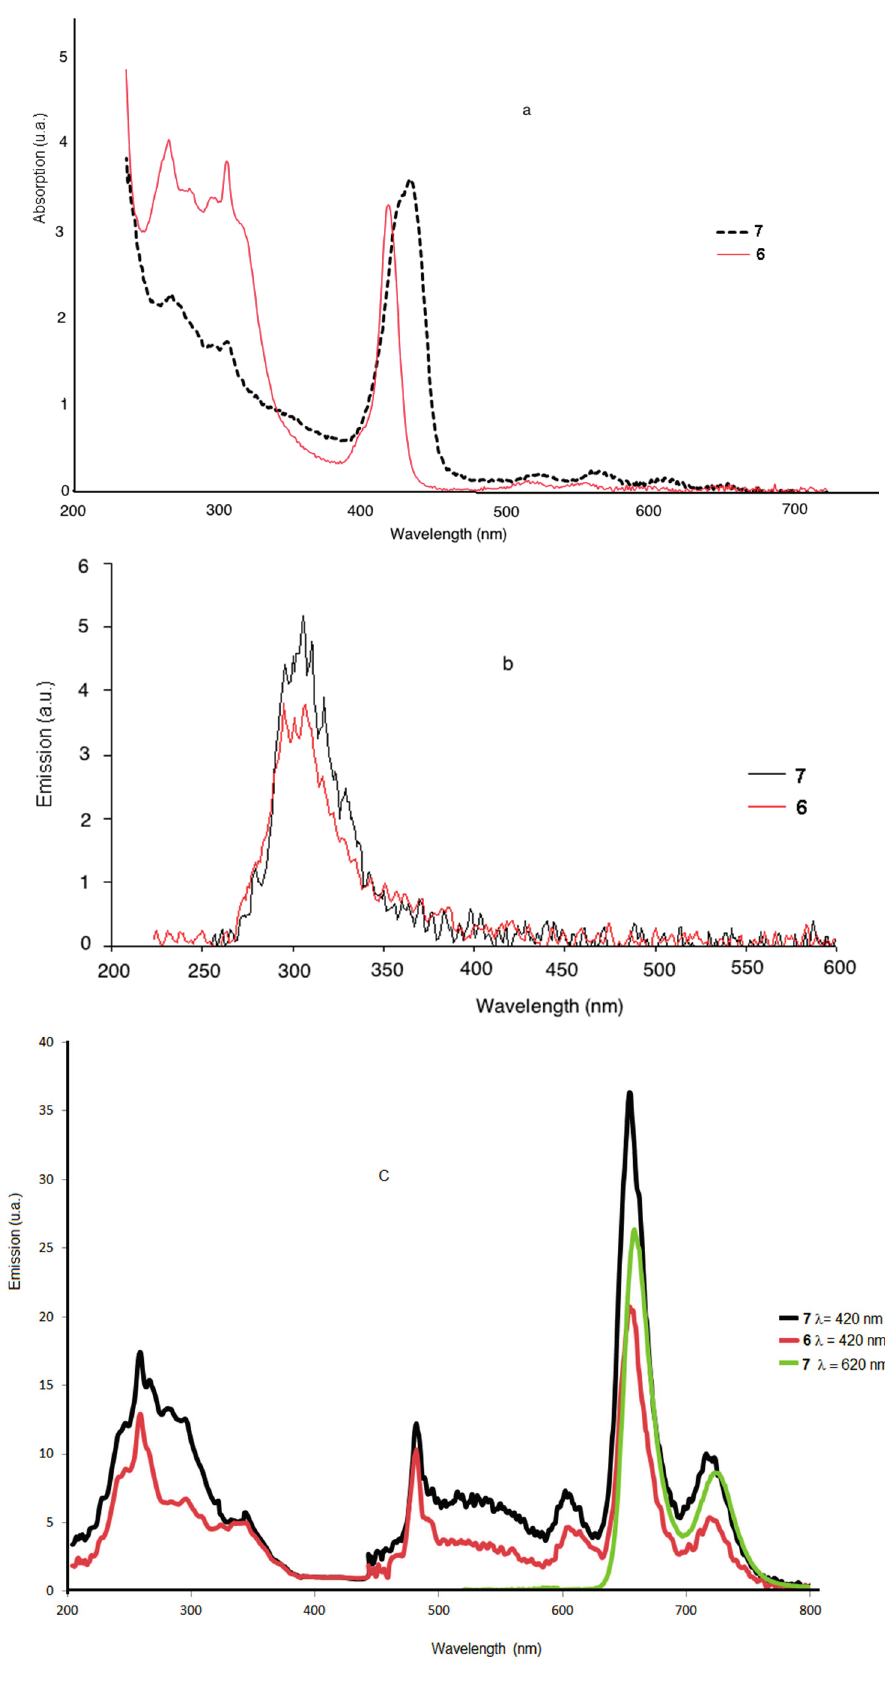
Figure 2. ( a ) Absorption ( b ) and ( c ) Fluorescence in chloroform at room temperature ( λ ex 250, 420 and 620 nm) of 6 and 7 in CH 2 Cl 2 at room